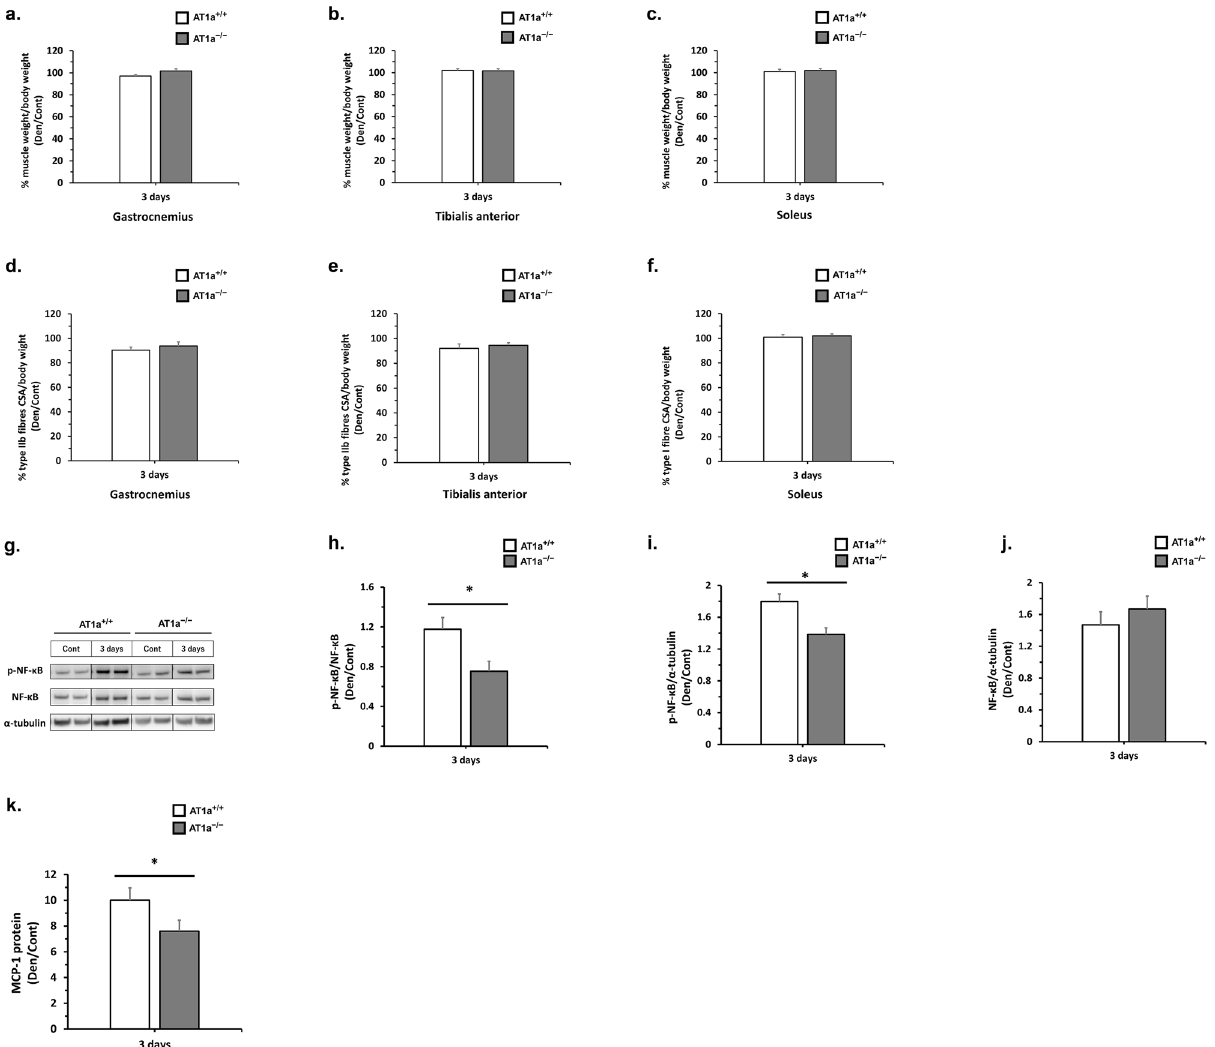
Figure 7. Evaluation of muscle wasting at 3 days postdenervation. ( a–c ) Change in skeletal muscle weight normalized to the body weight in denervated gastrocnemius ( a ), tibial anterior ( b ), and soleus ( c ) muscles at 3 days postdenervation. The graphs show the fold increase or decrease in each normalized muscle weight in the Den group compared with the Cont group. ( d–f ) Quantitative analysis of cross-sectional areas of type IIb and type I muscle fibers normalized to the body weight in gastrocnemius ( d ), tibial anterior ( e ), and soleus muscle ( f ) in the Den group compared with the Cont group at 3 days postdenervation. The graphs show the fold decrease in each cross-sectional area normalized to body weight in the Den group compared to the Cont group. ( g–j ) Protein expression levels of phosphorylated NF-κB and total NF-κB were evaluated by western blot analysis. Expression levels in each sample were normalized to α-tubulin expression levels and were shown as the fold increase or decrease in protein expression in the Den group compared with the Cont group. Relative protein expression was calculated for p-NF-κB/NF-κB ( h ), p-NF-κB/α-tubulin ( i ), and NF-κB/α-tubulin ( j ). Samples from the same experiment were processed in parallel for SDS-PAGE and western blotting using different gels and membranes, and the image data obtained were cropped. Entire images of western blotting are shown in online supplementary resource Supplementary Fig. S6. ( k ) Protein expression levels of MCP-1 were measured by ELISA. The graphs show the fold increase or decrease in protein concentration levels in the Den group compared with the Cont group. The protein concentrations of MCP-1 in each sample were normalized to total protein levels. The graph shows the fold increase in normalized MCP-1 protein in the Den group compared with the Cont group. AT1a +/+ -Cont group, n = 9; AT1a +/+ -Den group, n = 9; AT1a −/− -Cont group, n = 9; AT1a −/− -Den group, n = 10. Values are means ± SE. *P <